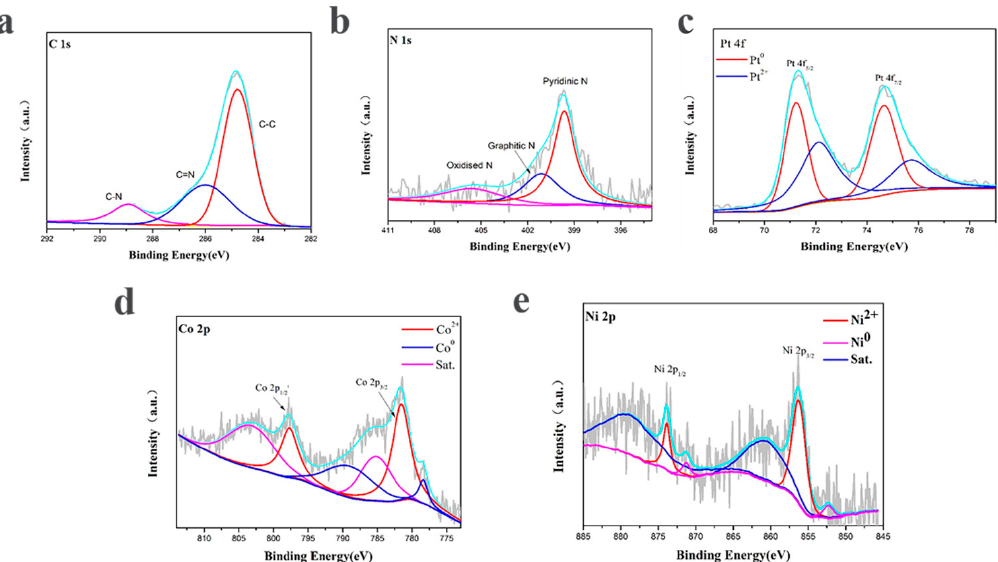
Figure 4. XPS spectra of PtNi/MNC-1-6: ( a ) C 1s; ( b ) N 1s; ( c ) Pt 4f; ( d ) Co 2p; ( e ) Ni 2p.